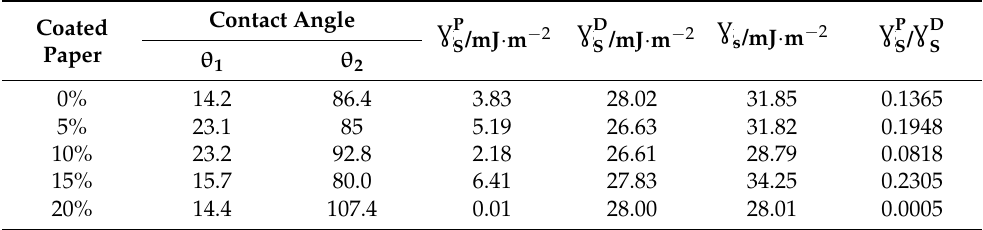
Figure 8. Differential scanning calorimetry (DSC) of papers coated with PVAc and its lignin copol- ymers containing different fractions of lignin. Table 2. Surface free energy and values of dispersion force of the blank paper and coated paper with PVAc and its copolymers containing different fractions of lignin.